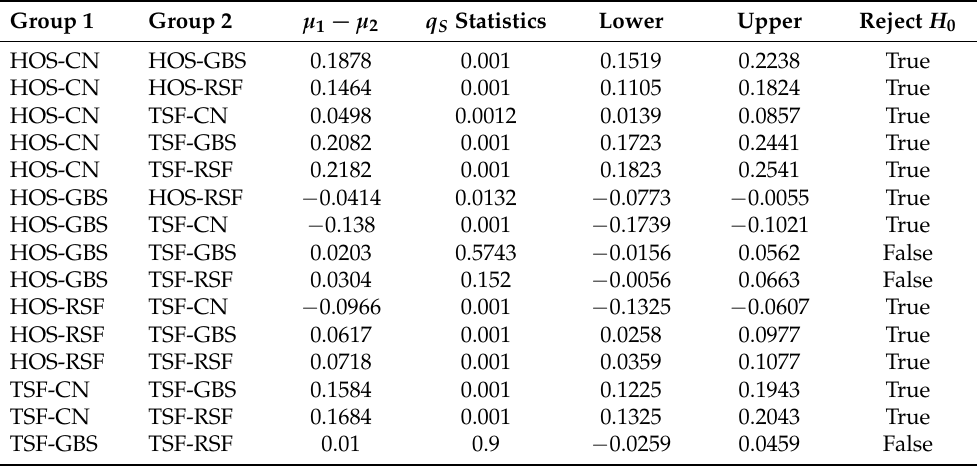
Table 5. The pairwise Tukey test q S statistics and lower and upper bounds for mean differences between each pair of groups. The null hypothesis H 0 : µ 1 = µ 2 was rejected at a significance level of α > 1 −